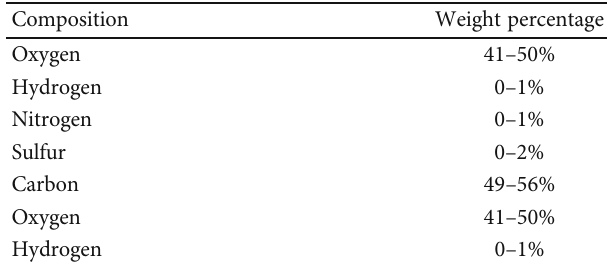
Table 2: Elemental analysis of graphene